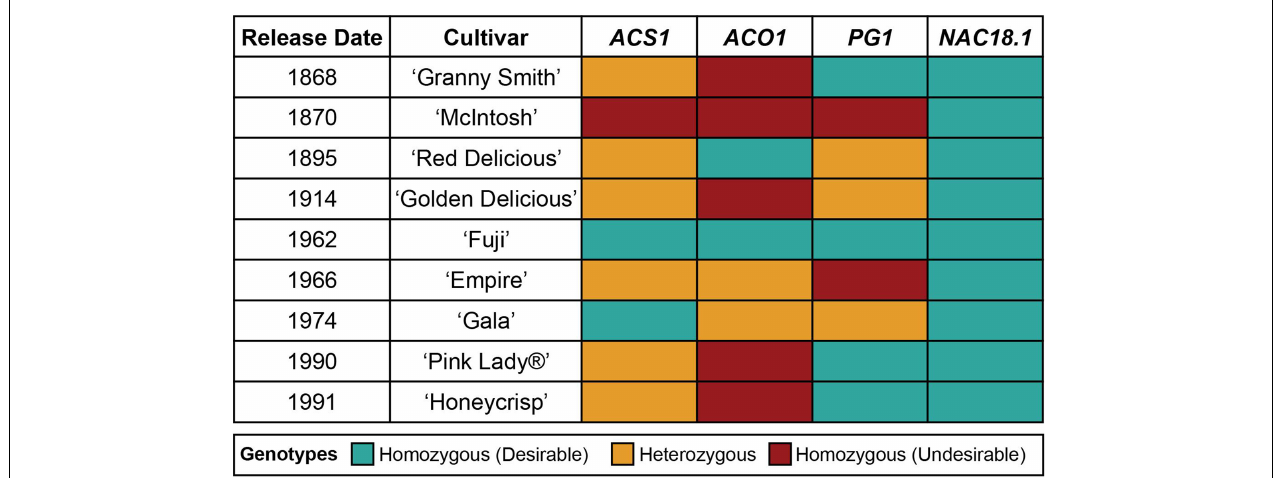
FIGURE 2 | Genotypes of four texture-related genetic markers across the top 9 apple cultivars sold in the United States (U.S. Apple Association). The “desirable” allele for each marker is defined as the allele that has been reported to lead to firmer apple texture.